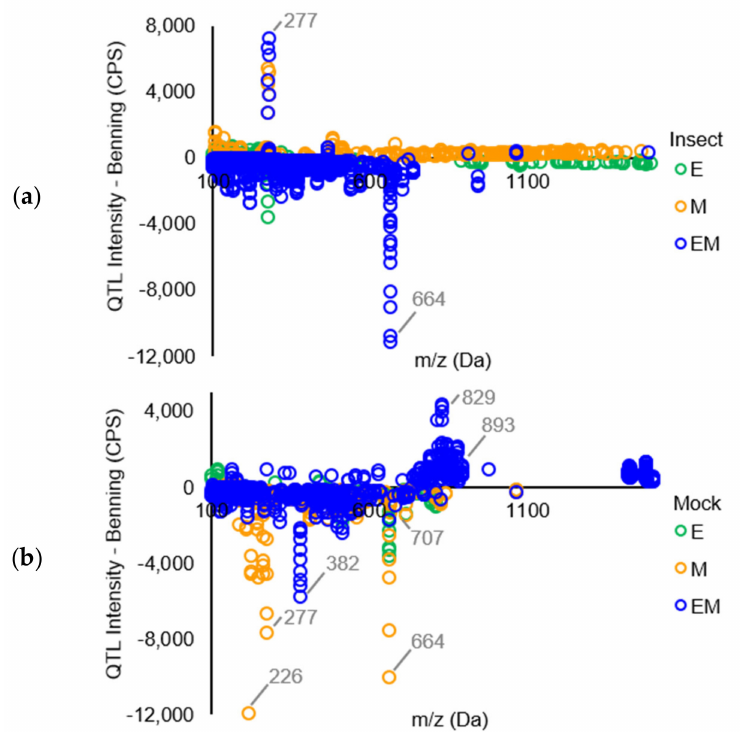
Figure 2. Comparison of average full scan mass spectra of soybean QTLs compared to Benning showing the increase or decrease of metabolites. Only mass spectra that were significantly different in intensity compared to Benning are shown. ( a ) Treatment with soybean looper for 72 h. ( b ) No insect